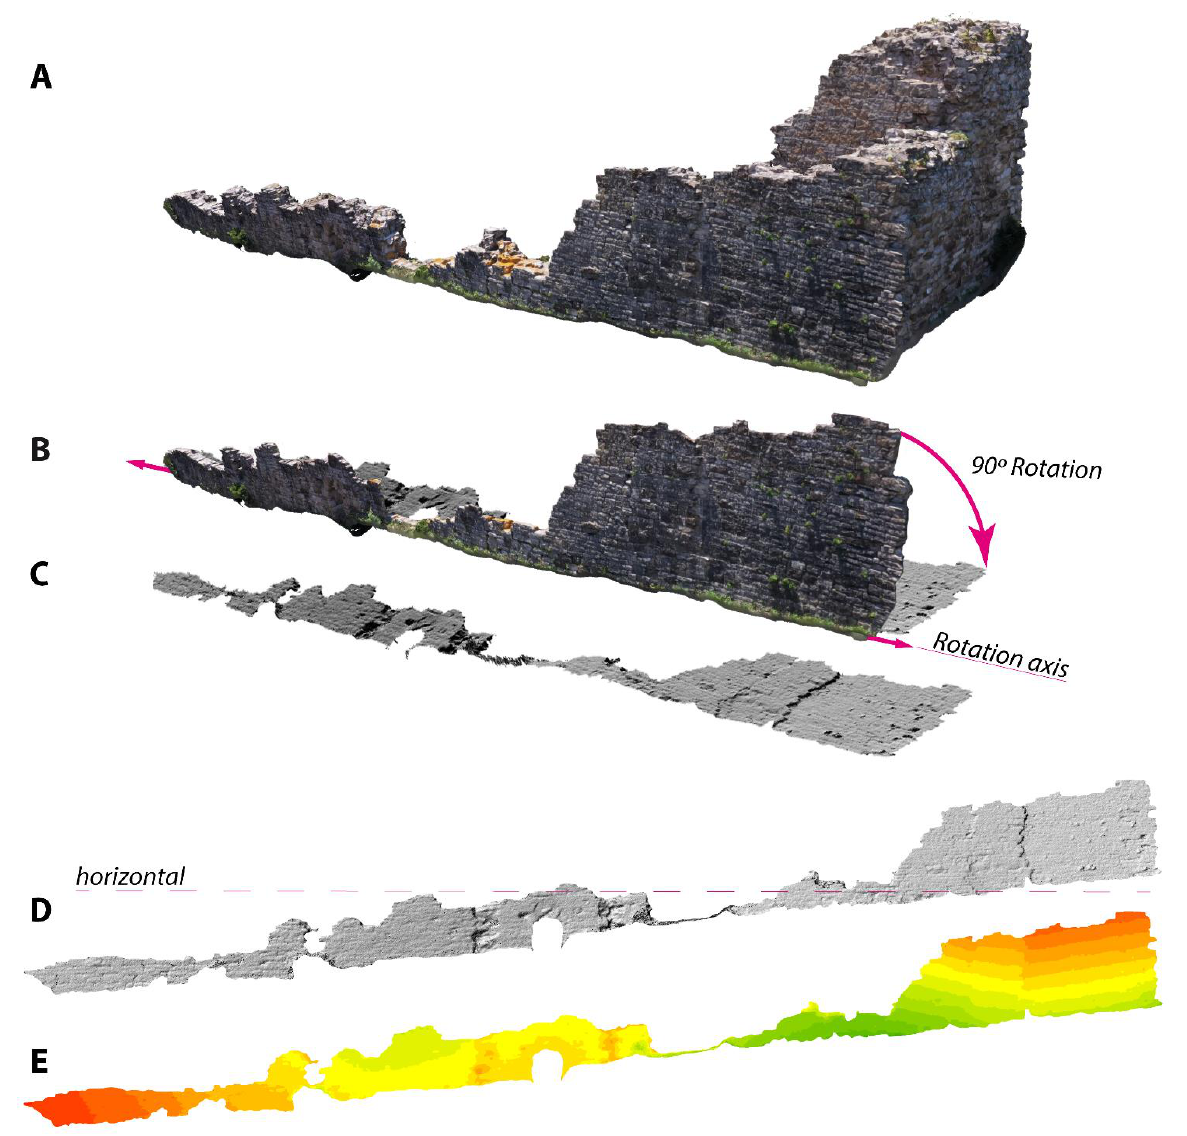
Figure 5. ( A ) A 3D model of the studied area reconstructing the North City-Wall Bastion from photogrammetry of drone aerial photographs. The overall orientation of the city wall is N162 E and shows strong damage from the earthquake. ( B ) The sense of rotation and axis of rotation of the original elevation points of the east-facing side of the wall in order to soundly operate in a GIS environment. ( C ) Hillshade model of the tilted DEM of the east-facing side of the city wall. ( D ) Map view (elevation view) of the DEM of the east-facing side of the city wall (after tilting); note that a horizontal guide has been added to ease reconstruction. ( E ) Hypsometric distribution of the deviation from the vertical (distance from the wall to the ration axis located at the base of the wall) in cm (color intervals each 10 cm) on the E side of the city wall; note the different sectors all constrained by the deformation caused by the earthquake.